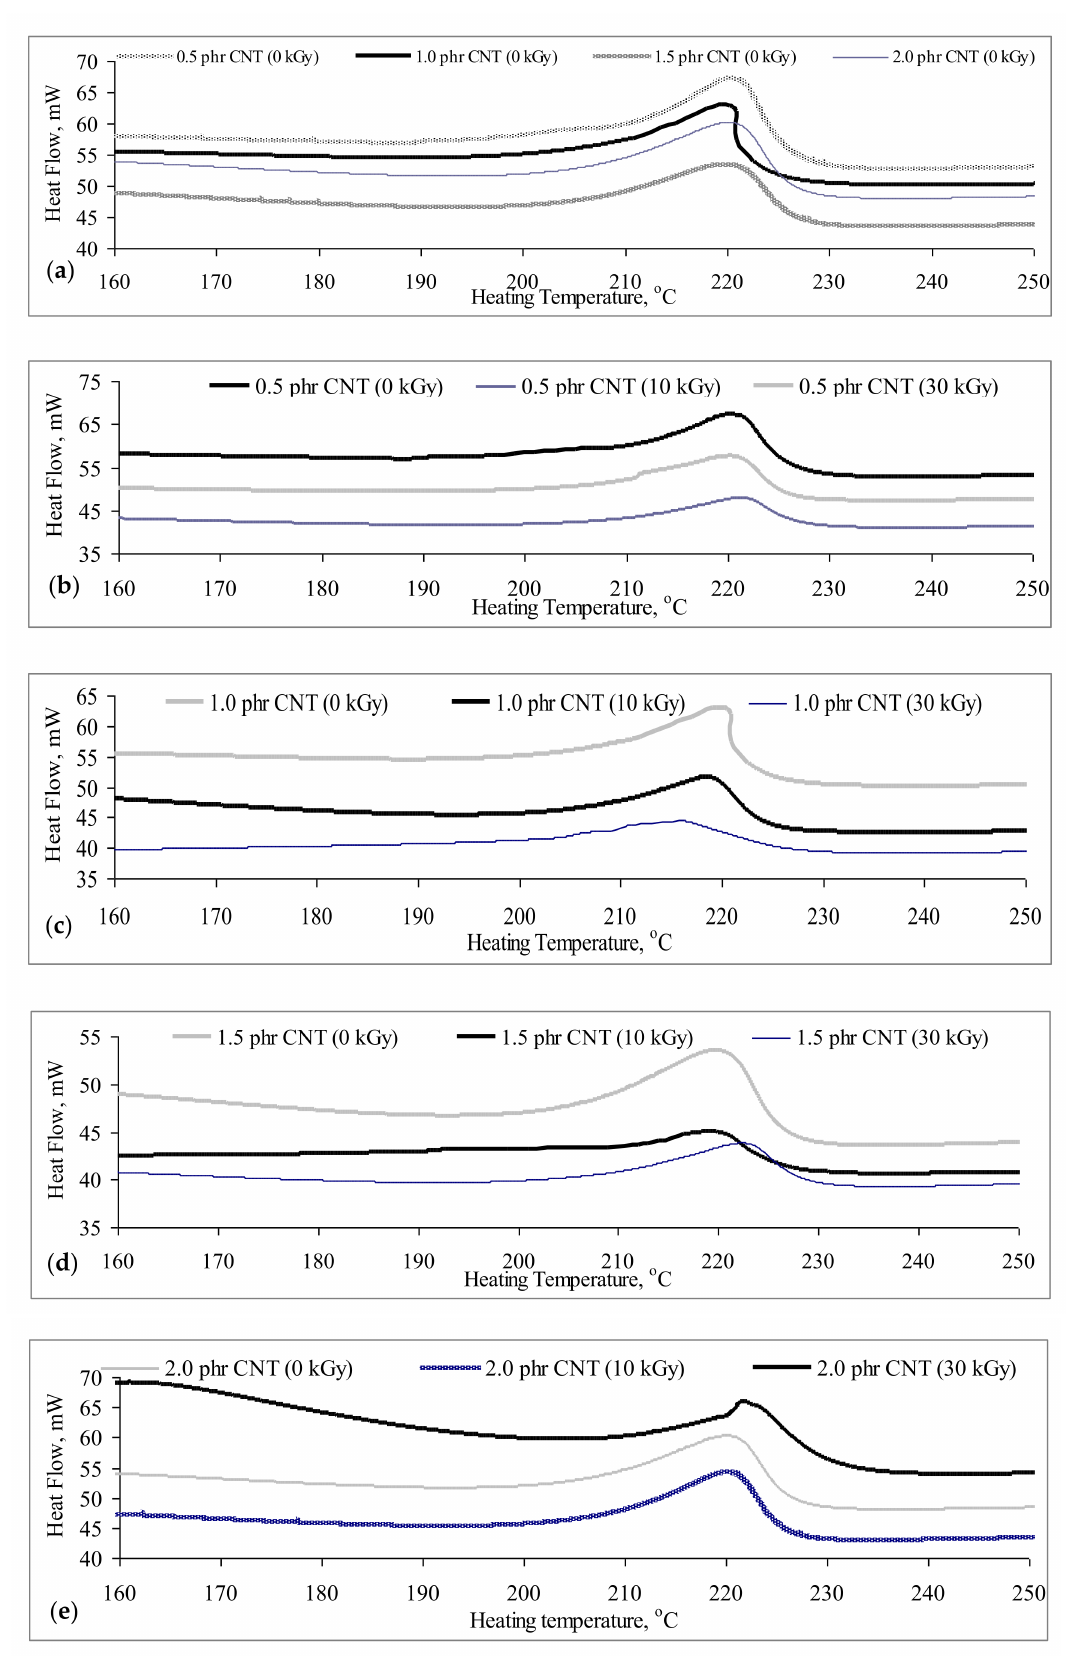
Figure 6. ( a – e ): DSC thermograms of carbon nanotubes (CNT) added PVOH blends under various irradiation